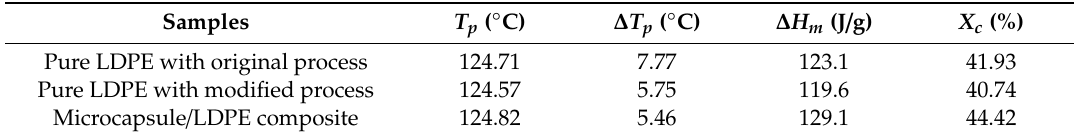
Table 2. Crystallinity and melting peak of samples.